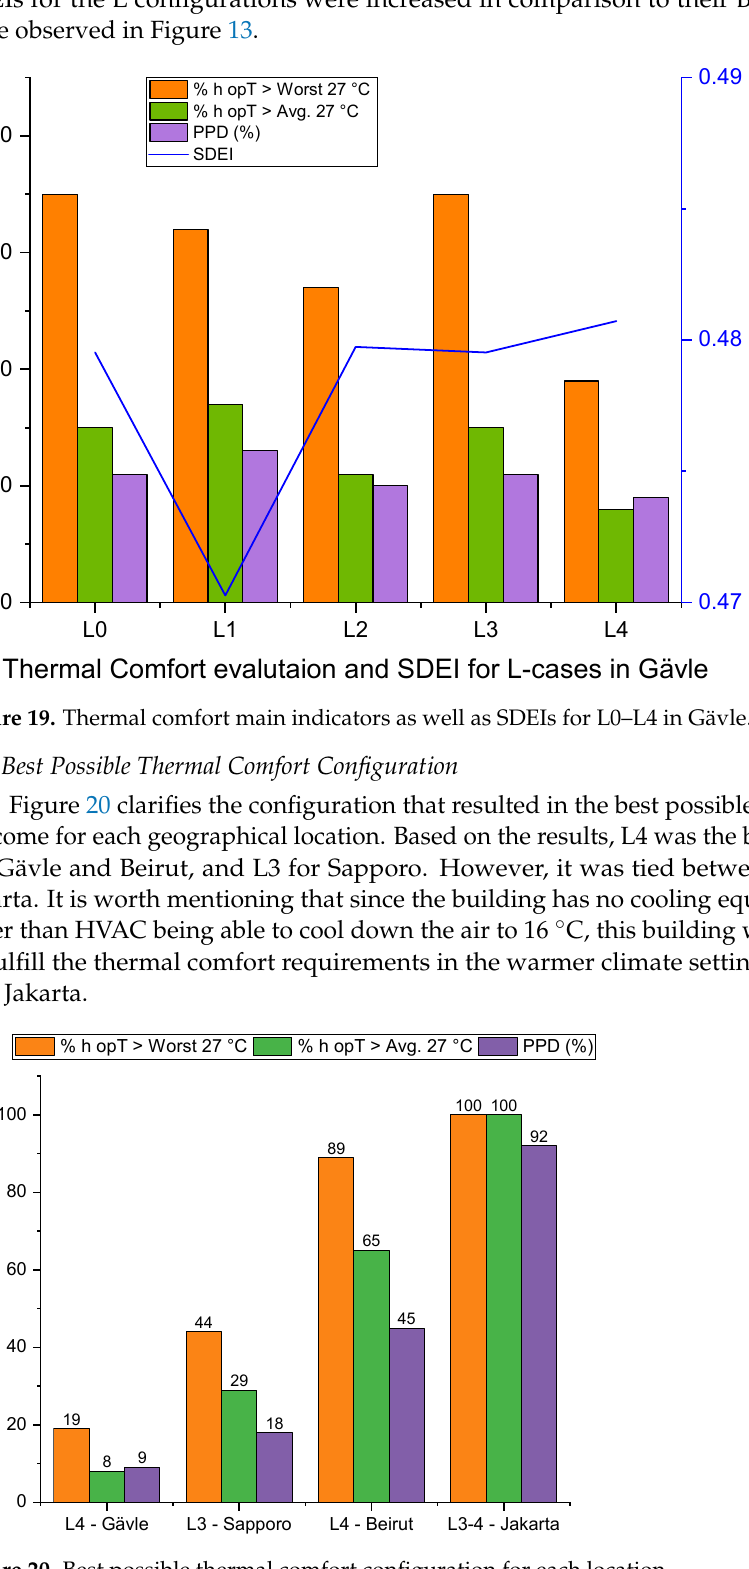
Figure 20. Best possible thermal comfort configuration for each location.